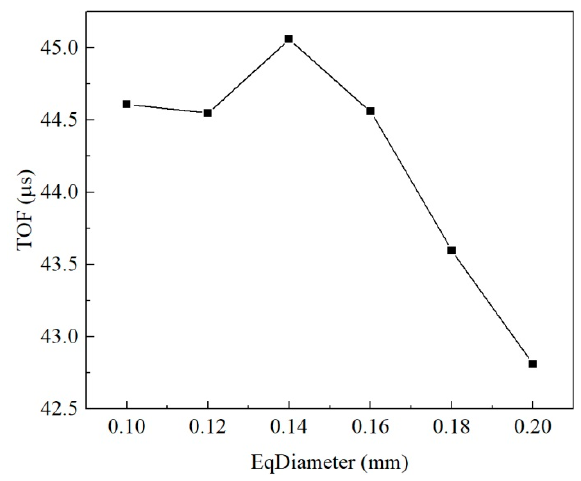
Figure 9. Relation between pore equivalent diameter and time of flight. In general, ultrasonic wave velocity was less susceptible to pore equivalent